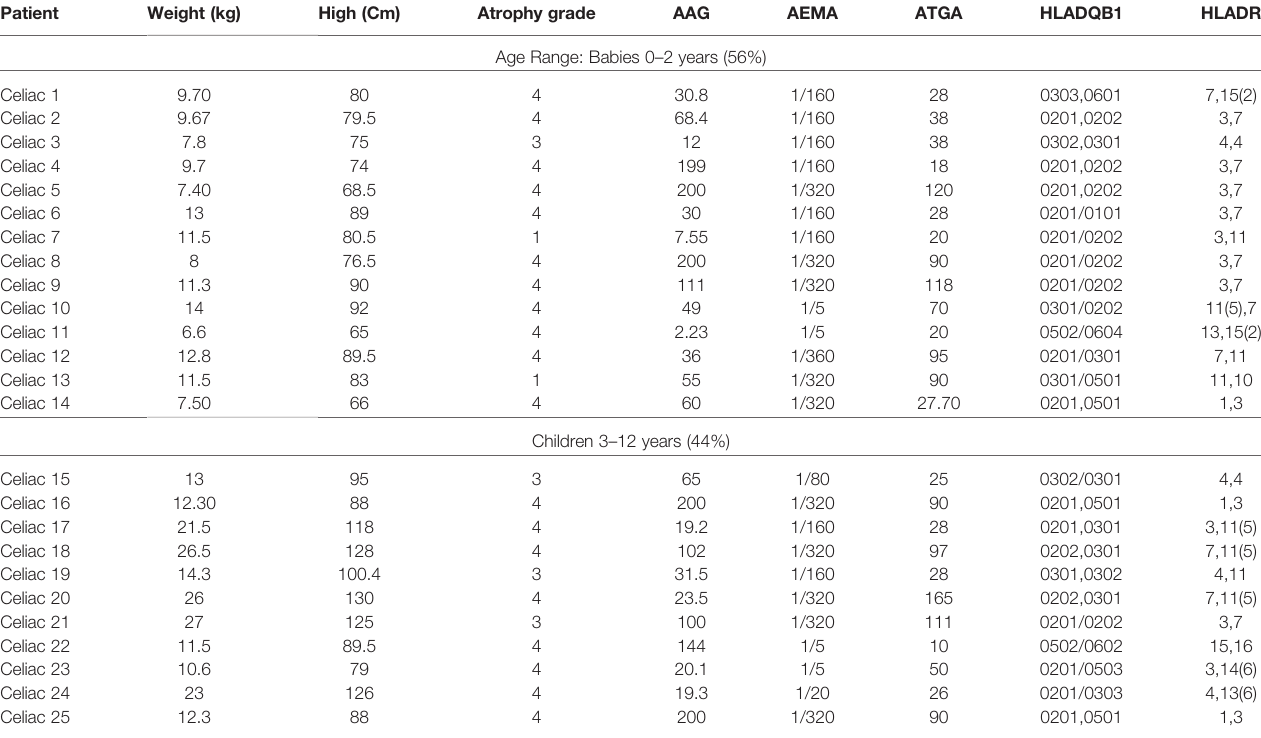
TABLE 1 | Clinical data of celiac patients.